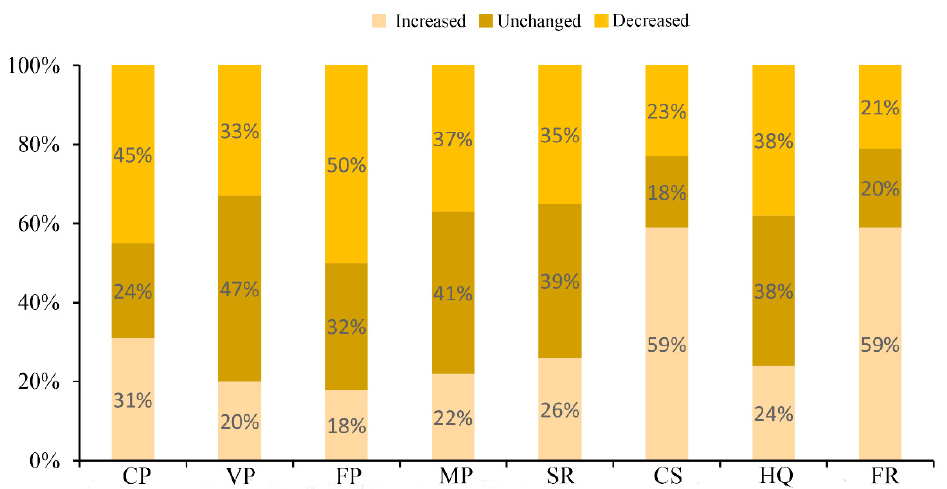
Figure 2. Huailai County stakeholders’ perception of changes in ecosystem services (ES) over the